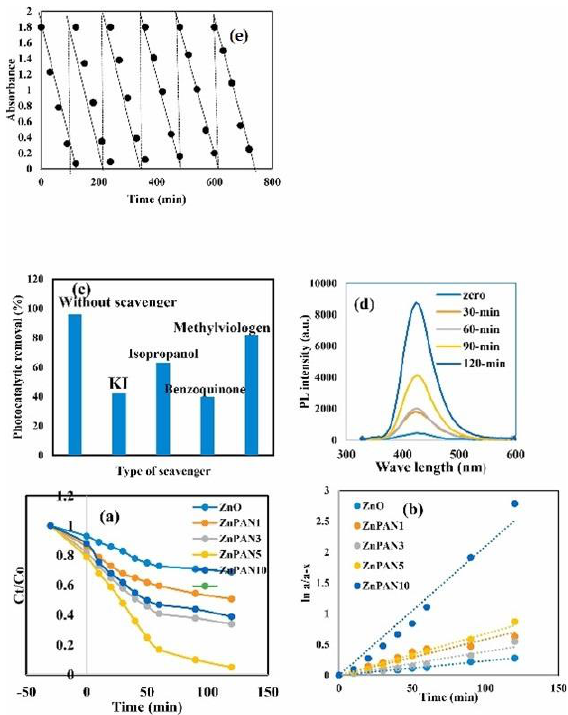
Figure 21. ( a ) Photocatalytic degradation of FLU dye over ZnO, ZnPAN1, ZnPAN3, ZnPAN5, and ZnPAN10, ( b ) Pseudo-first order kinetic for photodegradation of FLU dye over ZnO, ZnPAN1, ZnPAN3, ZnPAN5 and ZnPAN10, ( c ) The effect of scavengers on photocatalytic degradation of FLU dye over ZnPAN5, ( d ) PL spectrum for terephthalic acid on the sample ZnPAN5 ( e ) Re-cyclic of ZnPAN5 for five consecutive cycles [168].